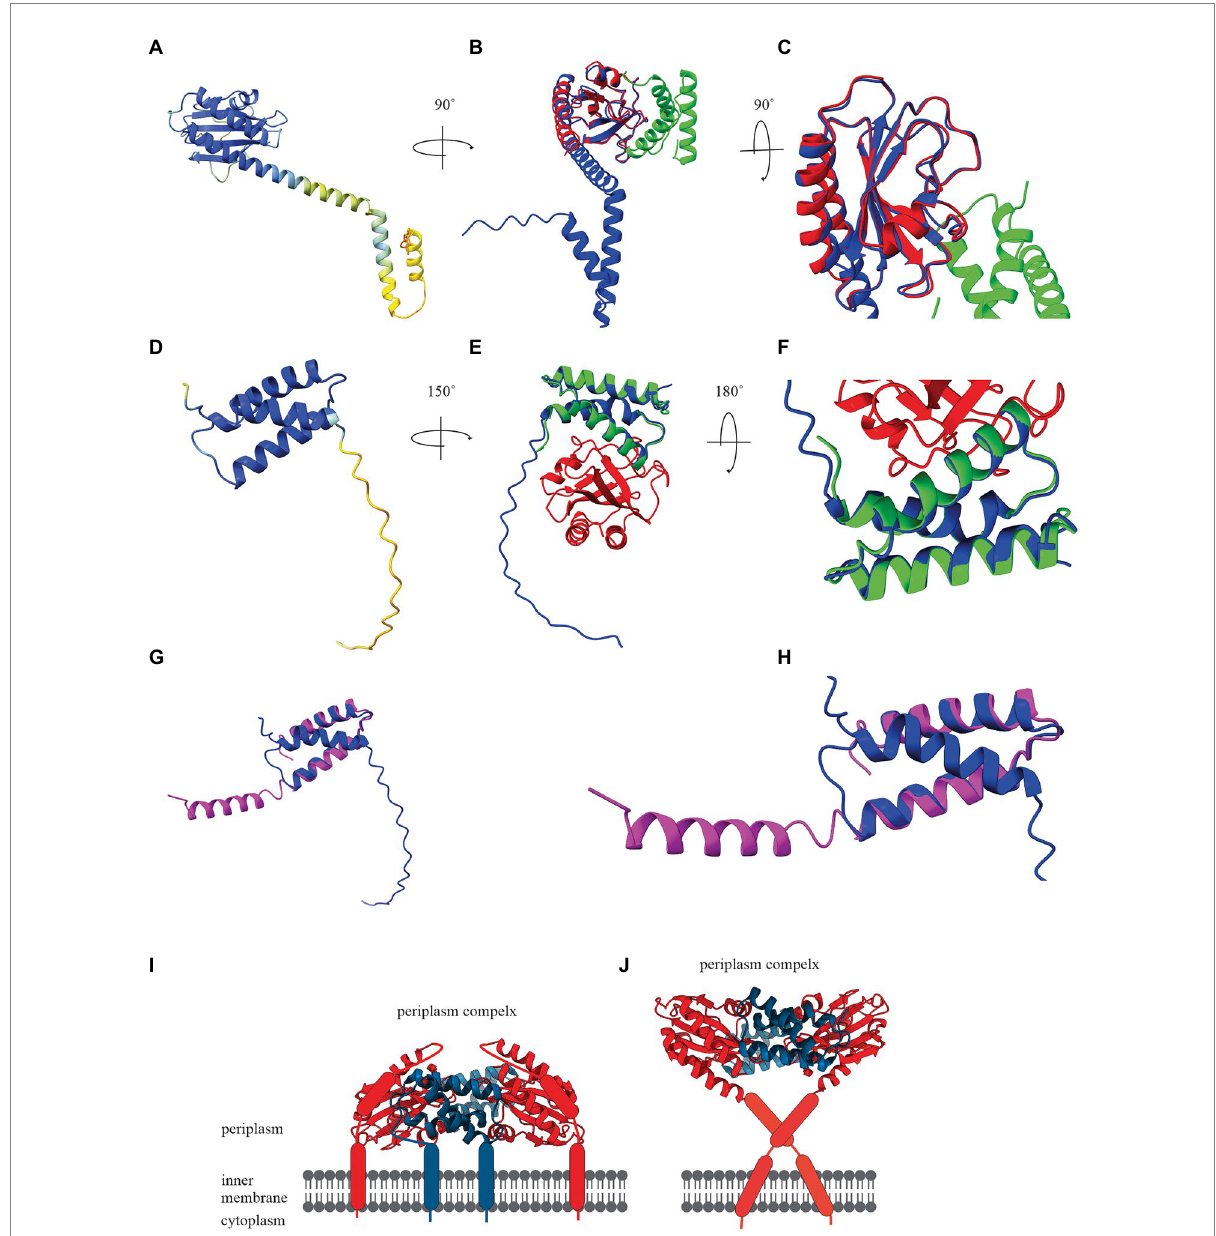
FIGURE 2 (A) AlphaFold Colab prediction of complete holin T structure. The colour of the predicted holin T structure represents the score of the predicted local distance difference test (pLDDT). (B) Structure comparisons of AlphaFold Colab predicted holin T (blue) and 6PSK(soluble domain of the resolved holin T and RI antiholin complex; RMSD = 0.688 angstroms). (C) An enlarged version of structure comparisons of AlphaFold Colab predicted holin T (blue) and 6PSK (red; soluble domain of holin T and green; soluble domain of RI antiholin). (D) AlphaFold Colab prediction of RI antiholin. The colour of the predicted RI antiholin structure represents the score of the predicted local distance difference test (pLDDT). (E) Structure comparisons of AlphaFold Colab predicted RI antiholin (blue) and 6PSK (soluble domain of the resolved holin T and RI antiholin complex; RMSD = 1.537 angstroms). (F) An enlarged version of structure comparisons of AlphaFold Colab predicted RI antiholin (blue) and 6PSK (red; soluble domain of holin T and green; soluble domain of RI antiholin). (G) Structure comparisons of AlphaFold Colab predicted RI antiholin (blue) and 6PSH (soluble domain of the resolved RI antiholin monomer; RMSD = 21.077 angstroms). (H) An enlarged version of structure comparisons of AlphaFold Colab predicted RI antiholin (blue) and 6PSH (purple). (I) RI–T complex model with RI SAR domain by Krieger et al. (2020). (J) RI–T complex model with cleavable signal peptide (new model) by Mehner-Breitfeld et al.